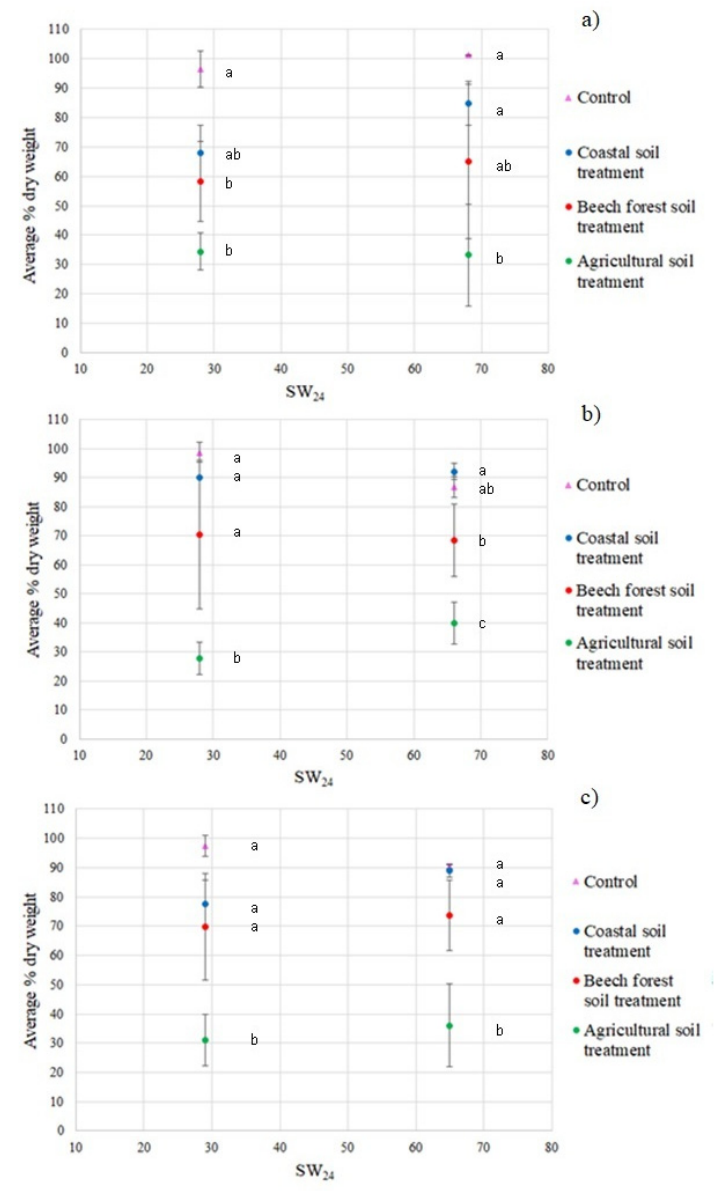
Figure 6. Average percentage dry weight at the end of the first degradation analysis experiment for the SW 24 value analyzed for the ( a ) 10% w / w AHum suspension; ( b ) 30% w / w AHum suspension; ( c ) 50% w / w AHum suspension. Two different curing times, leading to two resulting SW 24 values that are inversely proportional to the curing time values. Treatments sharing the same letter (within vertical comparisons) are not statistically significant for p < 0.05 (ANOVA; Tukey’s post hoc test). Bars presents mean value ± standard deviation.